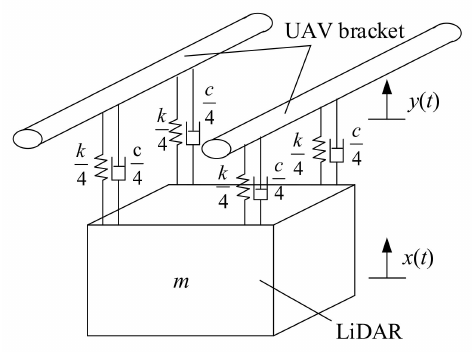
Figure 10. Front-loading radar dynamics model of the